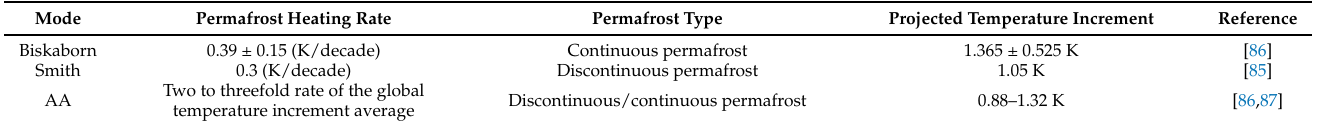
Table 6. Comparison of permafrost heating and its projection on the increased near-surface annual amplitude temperature of permafrost at the Mallik site from 1969 to